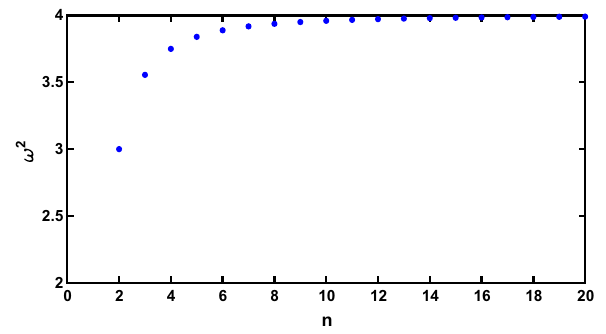
Fig. 3 The squared frequencies ω 2 of the vibrational states as a func- tion of parameter n for an isolated kink or antikink